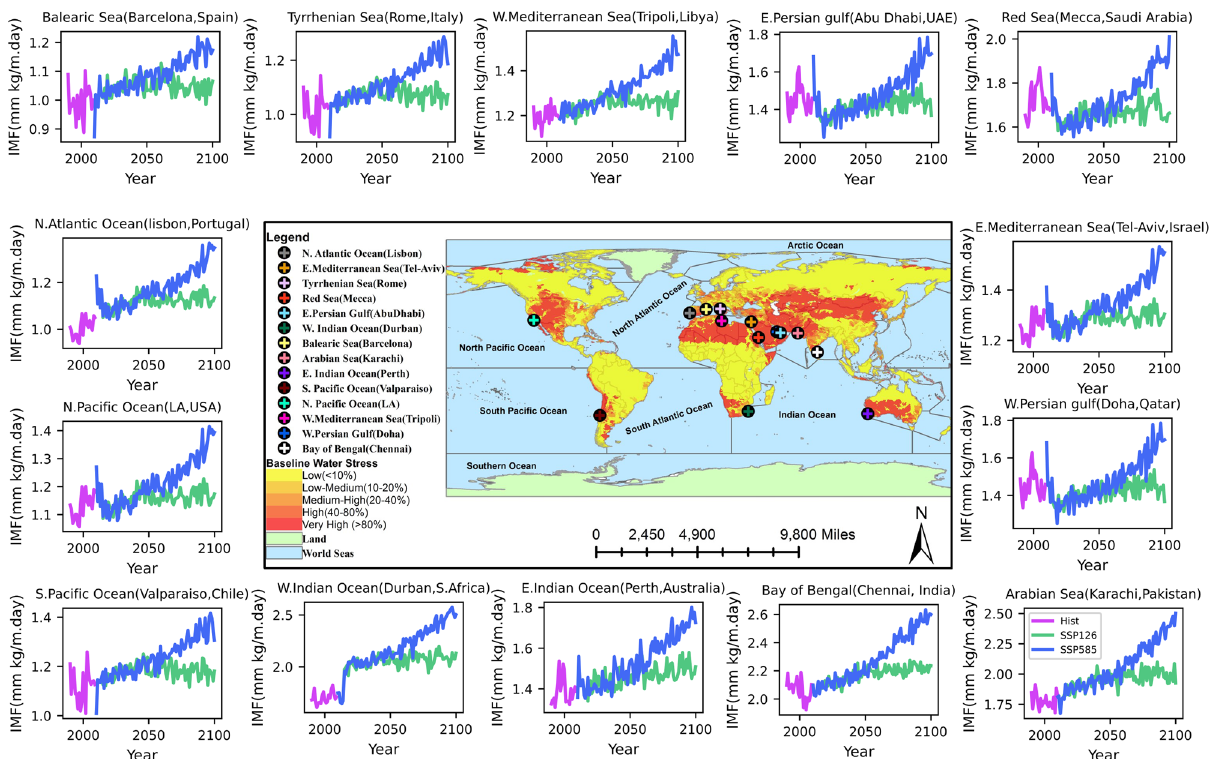
Figure 4. Projection of integrated moisture flux at 14 selected sites obtained from CESM2 WACCM model output. Integrated moisture flux value is in a million kg per day per m width of an atmospheric column from 10 m to 110 m above the sea level. The pink line indicates the historical estimate of yearly mean integrated moisture flux from 1990 to 2019 using the ERA5 data; the blue line is the integrated moisture flux for the SSP585 scenario from 2020 to 2100, and the green lines are the projection of integrated moisture flux for the SSP126 scenario from 2020 to 2100. The latter two are obtained using CESM2-WACCM global circulation model (GCM) data. Due to the mismatch between the spatial resolution of the two datasets, some locations exhibit rapid transitions. [Figures created using Python script and composited with Microsoft Publisher 365